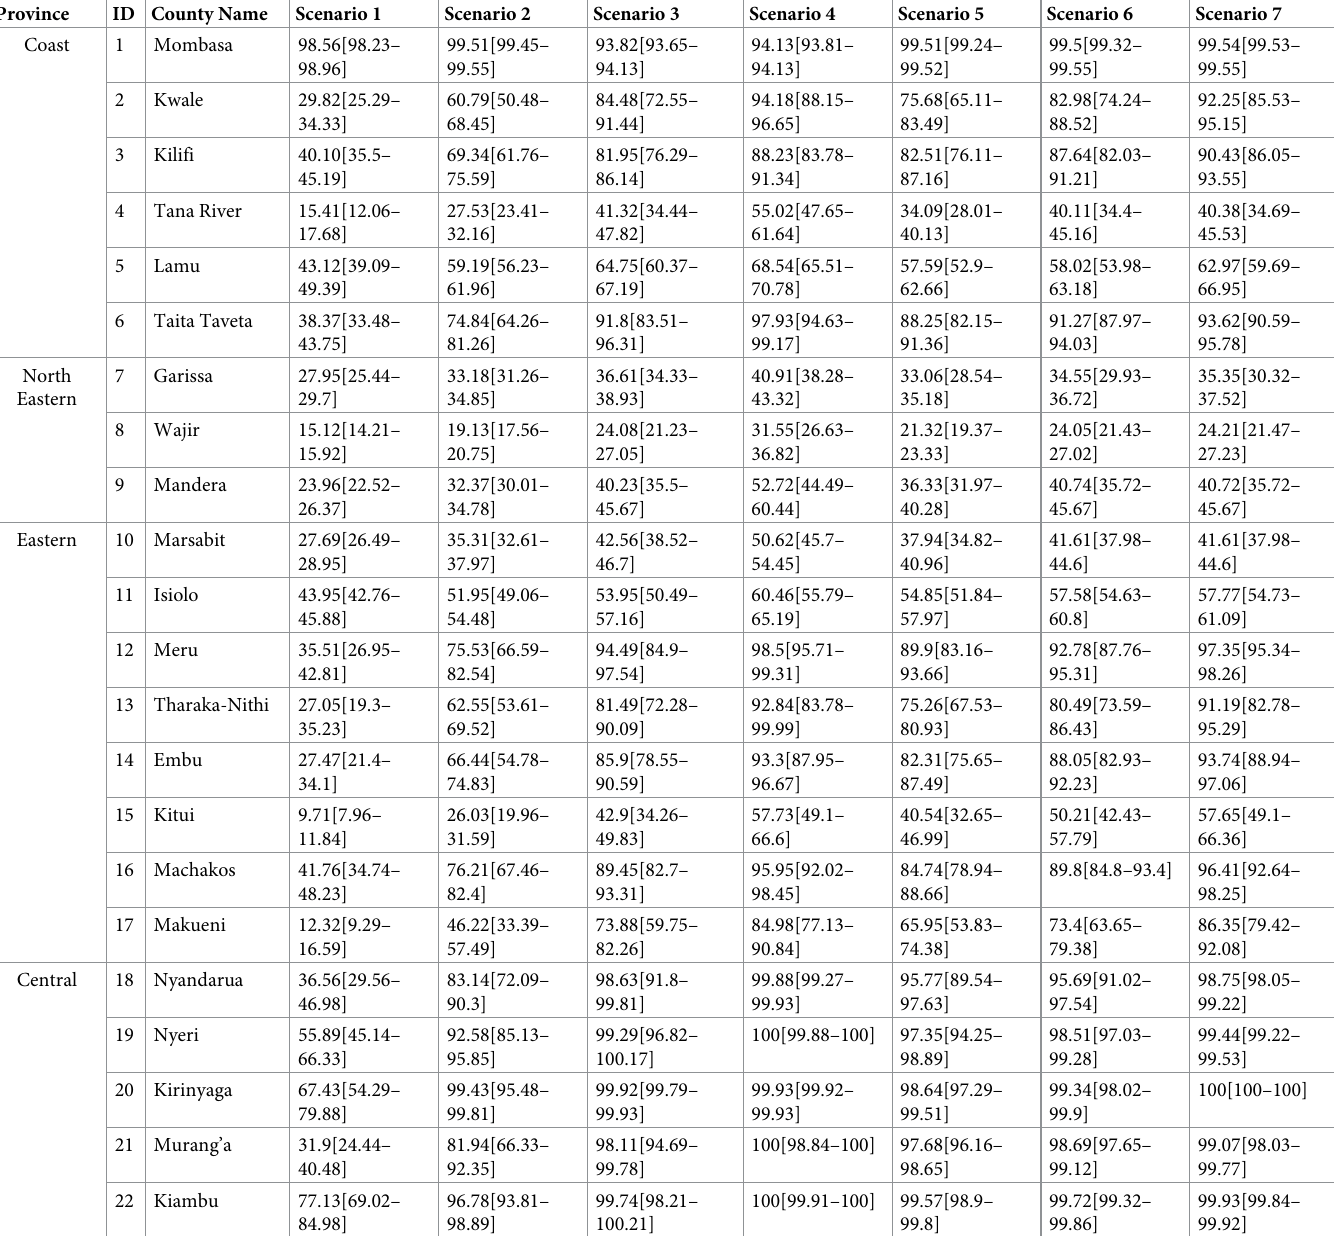
Table 3. The proportion of proportion within 1-hour travel time of the nearest urban centre in Kenya in 2019 for seven travel scenarios; walking only (scenario 1), bicycle only (scenario 2), motorcycle only (scenario 3), vehicle only (scenario 4) walking followed by motorcycle transport (scenario 5), walking followed by vehicle transport (scenario 6) and walking followed by motorcycle and then vehicle transport (scenario